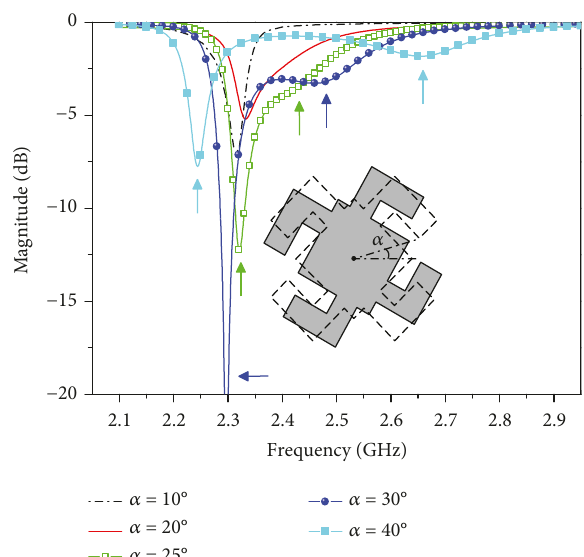
with di ff erent rotated angles α